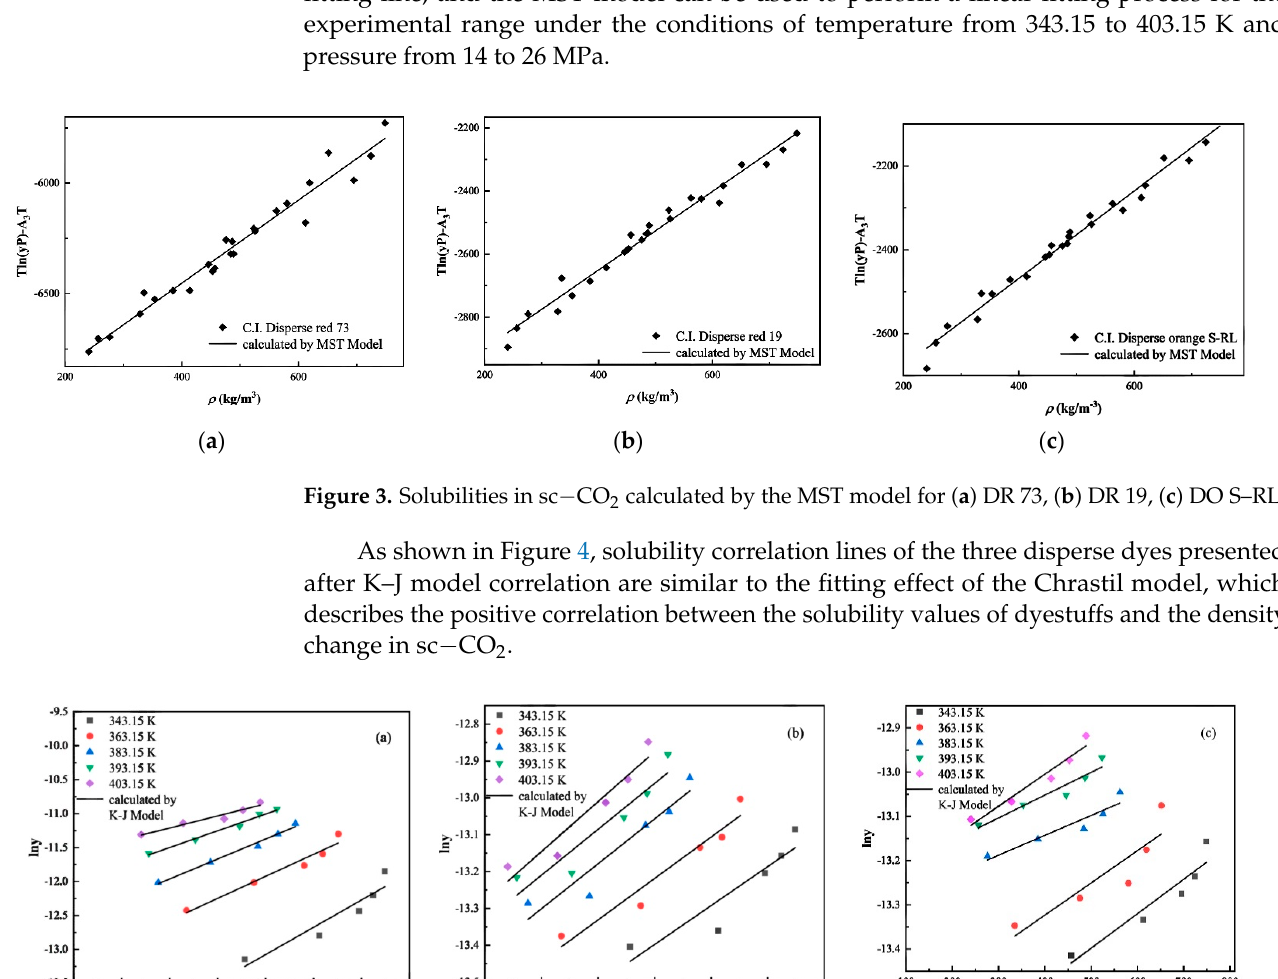
Figure 4. Solubilities in sc − CO 2 calculated by the K–J model for ( a ) DR 73, ( b ) DR 19, ( c ) DO S − RL.